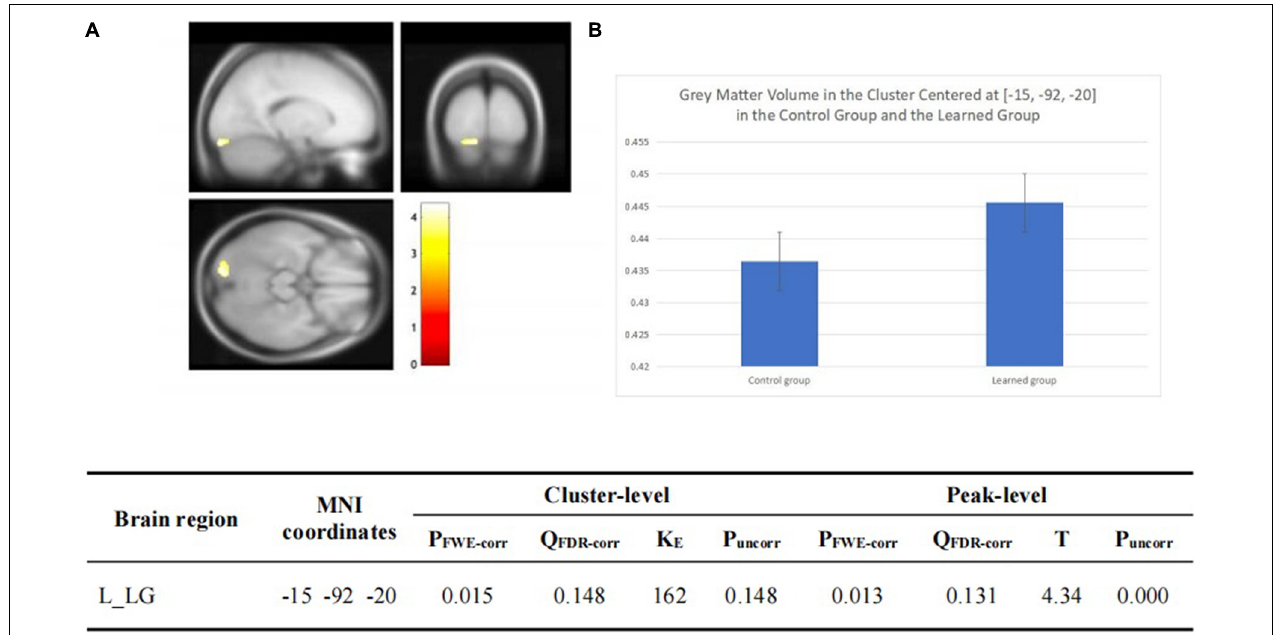
FIGURE 2 | (A) Statistical parametrical maps (threshold at P < 0.001, uncorrected for display purposes) showing regions of increased gray matter volume in the Chinese learned group when compared with the control group via VBM. Sex, ages, AoA-L2, the number of languages learned, Raven’s performance were considered as covariates and then were regressed out in the statistical analysis. Region in the left LG showed significant difference after correction for multiple comparisons using small volume corrections ( P < 0.05). (B) Greater GMV in the cluster centered at (–15, –92, –20) in the learned group than the control